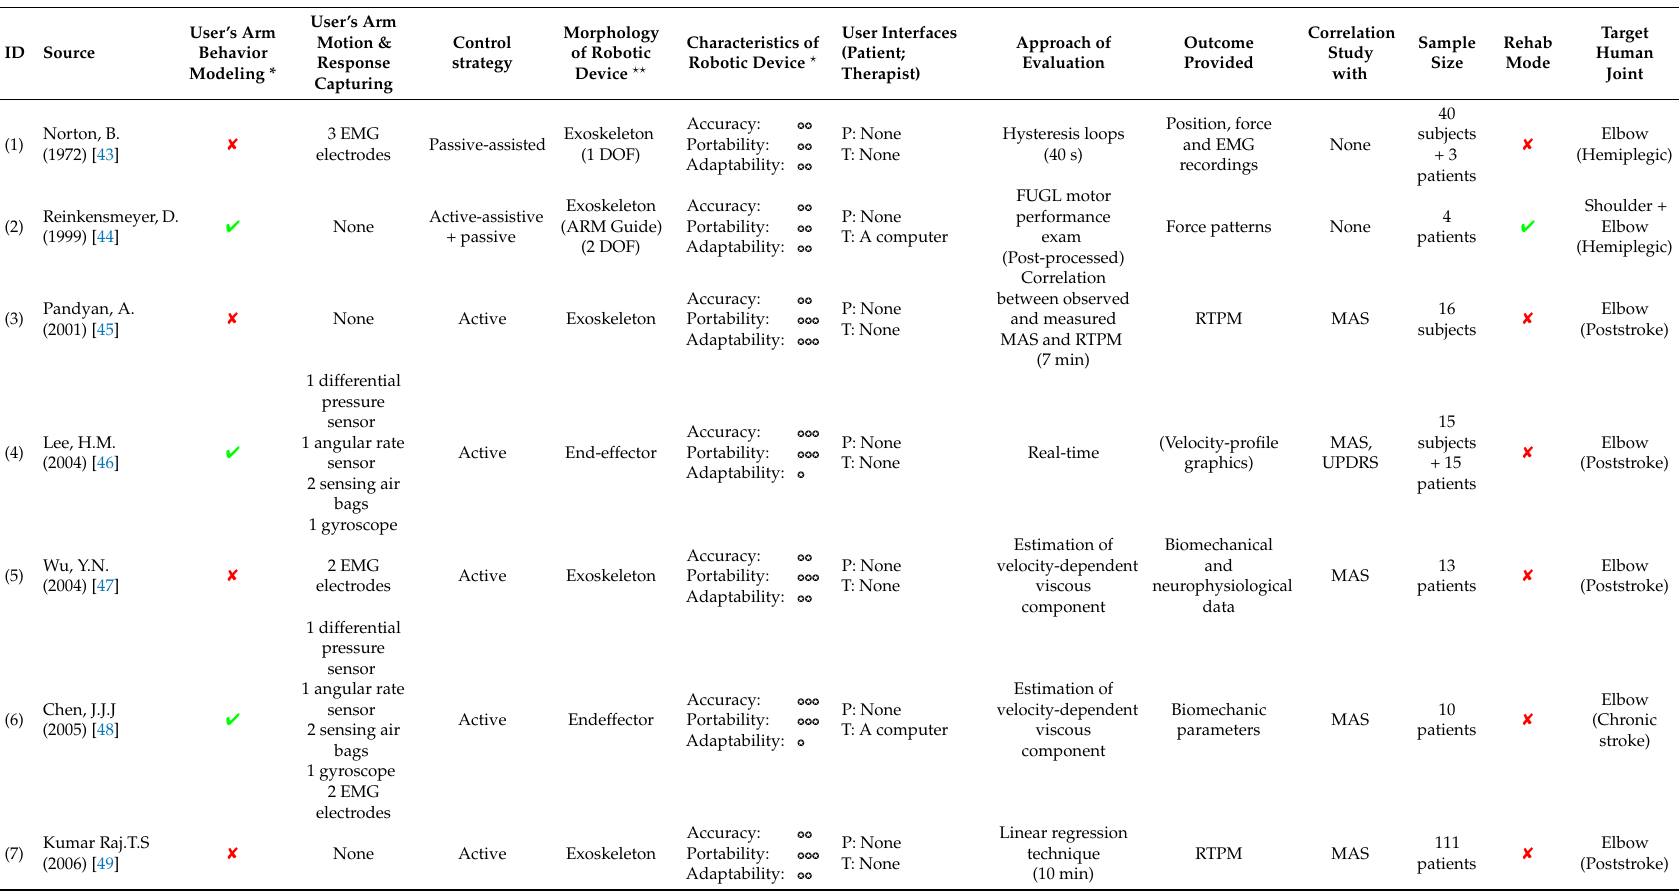
Table 3. Summary of automatic systems for upper limb spasticity